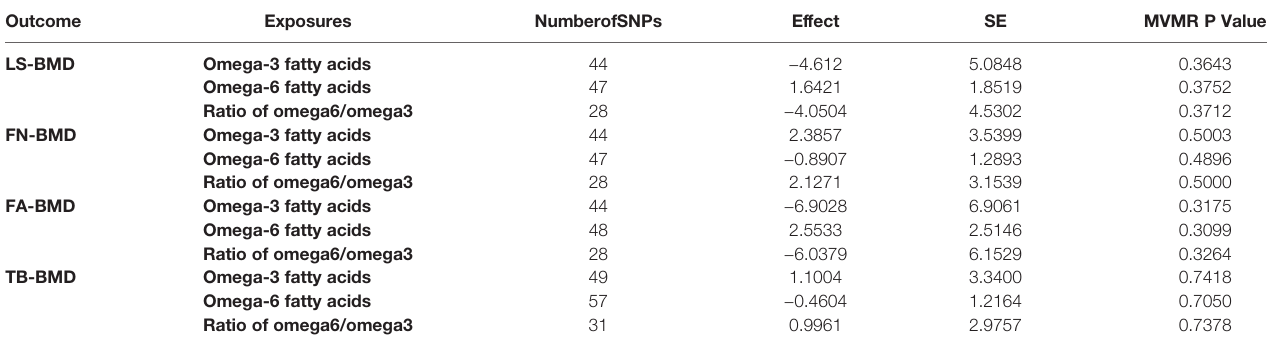
TABLE 3 | MVMR result after adjusting the interactions between FAs.